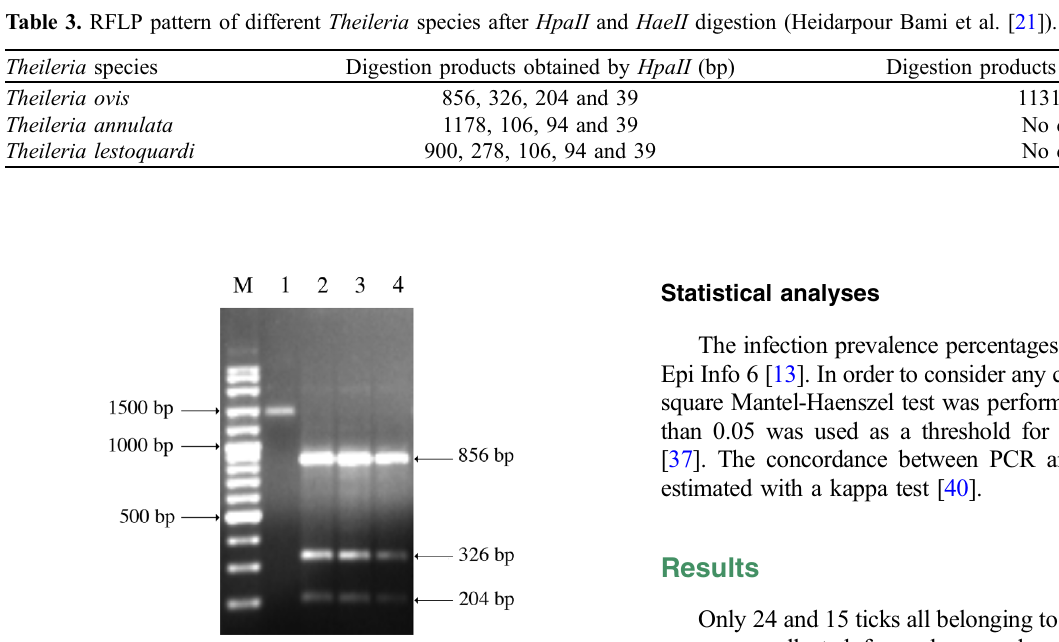
Figure 2. Digestion pattern of nested Theileria spp. 18S rRNA gene PCR products by HpaII . Lane M: 100 bp ladder; lane 1: Theileria spp. DNA; lanes 2–4: Theileria ovis (856, 326 and 204